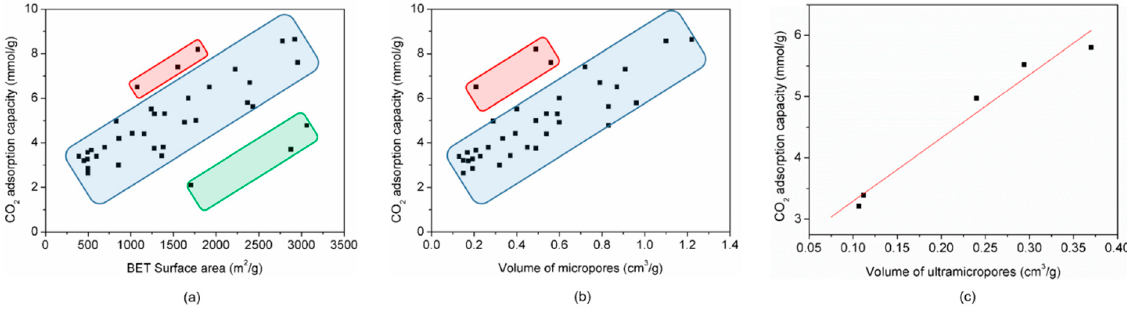
Figure 3. Plots of ( a ) CO 2 uptake (1 bar, 273 K) versus BET surface area; ( b ) CO 2 uptake (1 bar, 273 K) versus volume of micropores; ( c ) CO 2 uptake (1 bar, 273 K) versus volumes of ultramicropores for cellulose-, hemicellulose- and lignin-derived porous carbons.